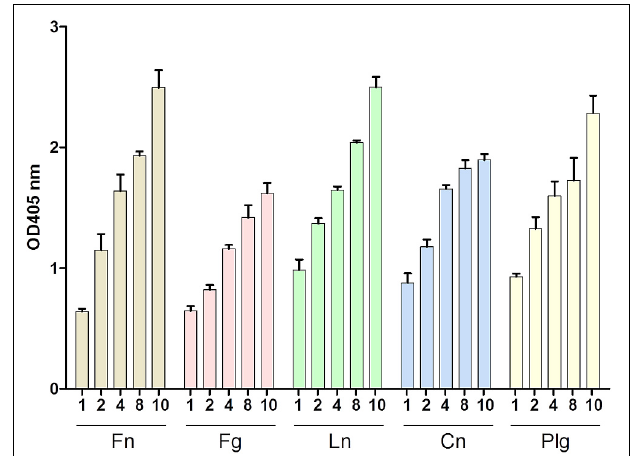
FIGURE 6 | Binding of SlEno to extracellular matrix (ECM) proteins. ECM proteins (fibronectin, Fn; fibrinogen, Fg; laminin, Ln; collagen type IV, Cn; and plasminogen, Plg) were immobilized to microtiter plates and incubated with rSlEno (10 µ g/ml) for 2 h. After washing, the rSlEno was detected using anti-SlEno rabbit antibodies as primary and anti-rabbit goat-AP as secondary antibodies. Results are shown as the mean of four independent experiments with the standard deviation